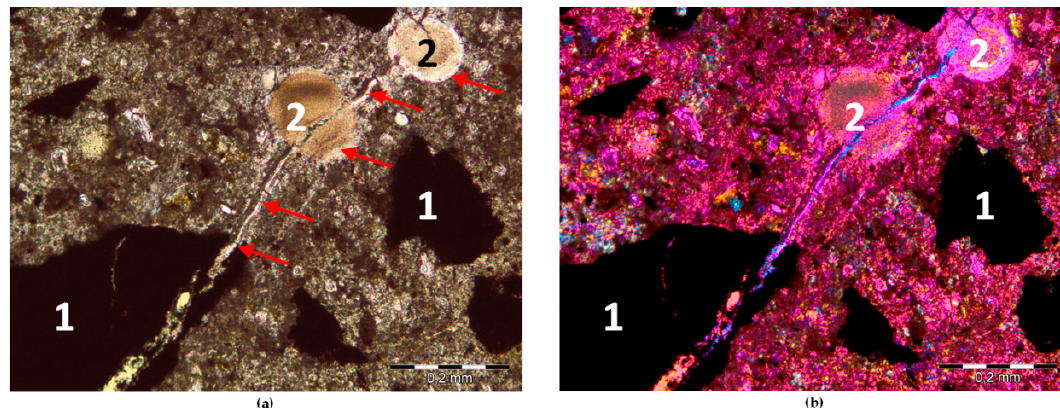
Figure 6. Post-mortem analysis on thin section, mortar with hematite H1: ( a ) PPL; ( b ) XPL_G;